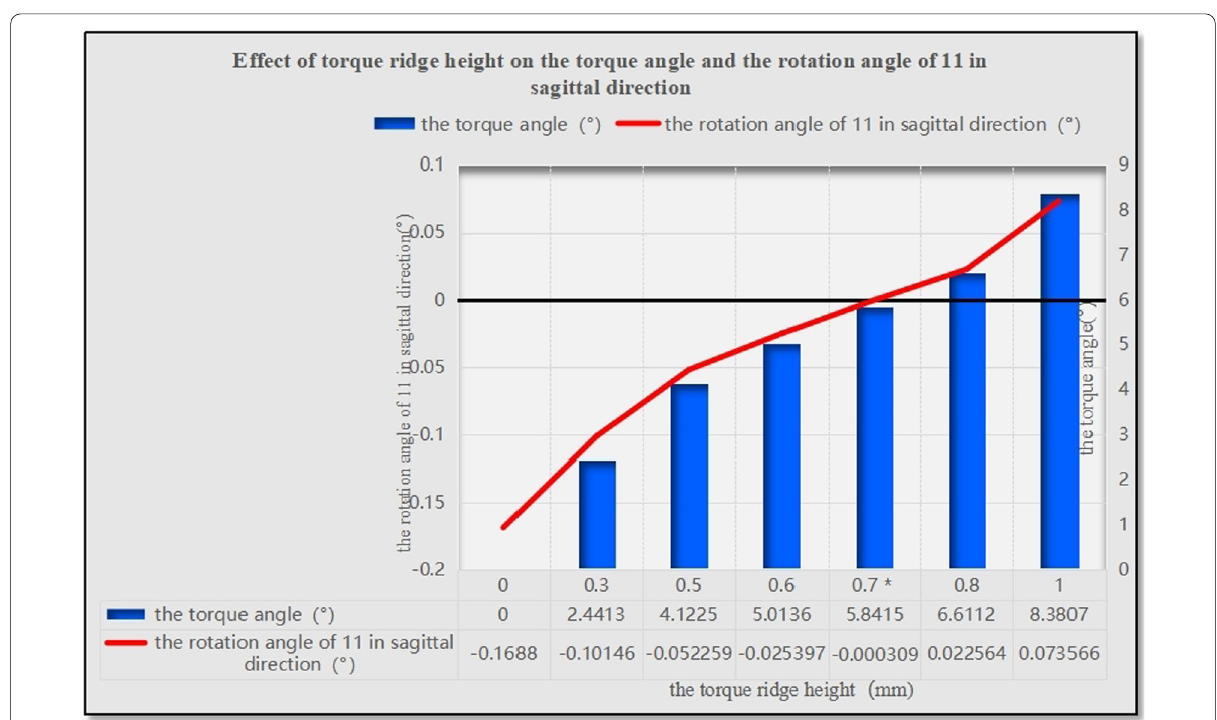
Fig. 5 The rotation angle of 11 in the sagittal direction with different power ridge heights when the axial inclination of 11 was 105°. *When the power ridge height is 0.7 mm, the rotation angle of 11 was close to 0° and the displacement trend of 11 was most close to bodily